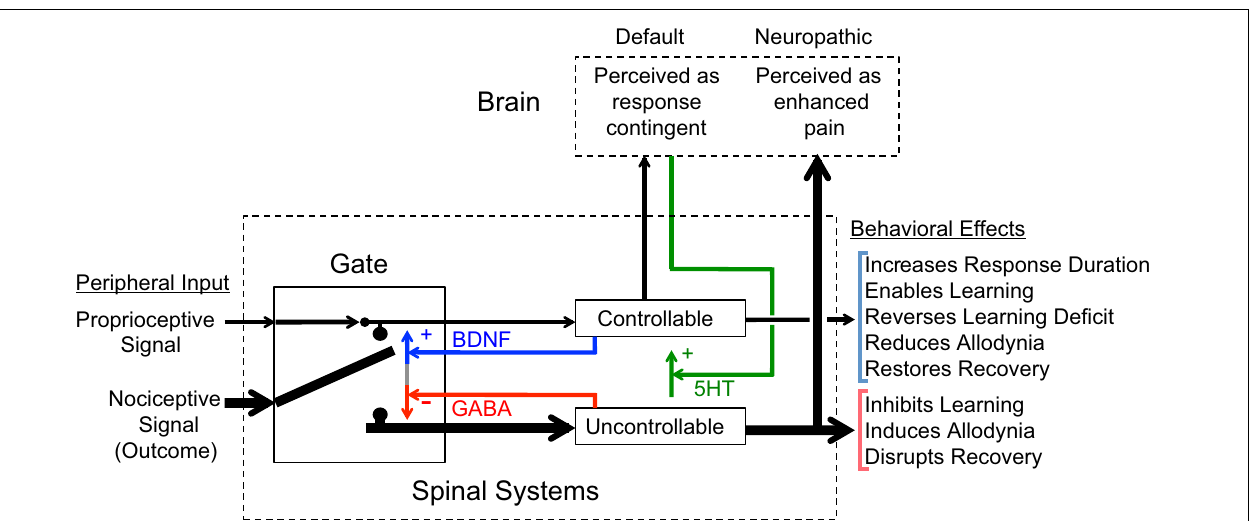
FIGURE 11 |A model of the processes that underlie the spinal consequences of controllable versus uncontrollable stimulation. It is assumed that proprioceptive signals provide an indication of current limb position and that the system is biologically prepared to detect the relationship between this cue and the onset of a nociceptive stimulus (preparedness is represented by initial position of the nociceptive input, which is tilted in favor of behavioral control).When a relation is detected, the stimulation is encoded as controllable.This process promotes adaptive behavior (e.g., an increase in response duration), enables learning, prevents and reverses the learning deficit, attenuates the allodynia elicited by uncontrollable shock or peripheral inflammation, and prevents nociceptive stimulation from adversely affecting recovery. Findings reported above suggest that these adaptive processes are linked to BDNF (blue), which could enable learning and attenuate the consequences of uncontrollable